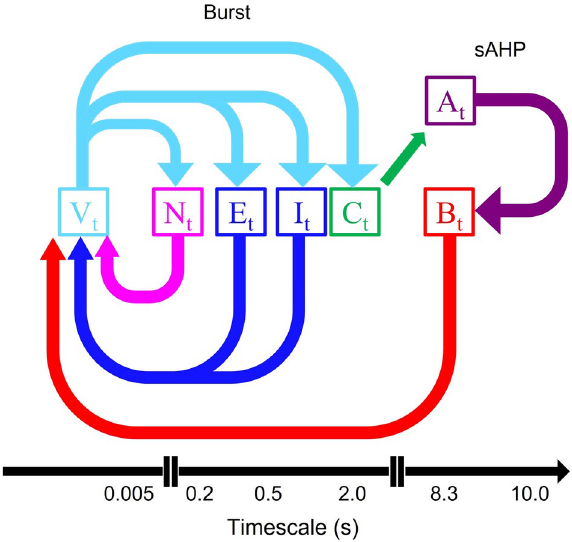
Figure 1. Model variables and relationships. A schematic of the relationships in the model. Each arrow represents the effect on a variable. Membrane voltage ( V t ) causes changed in potassium opening probability ( N t ), acetylcholine release ( E t ), GABA release ( I t ), and calcium influx ( C t ). Calcium affects cAMP concentration ( A t ) and TREK1 opening ( B t ). TREK1 ( B t ), acetylcholine ( E t ), GABA ( I t ), and potassium opening probability ( N t ), then affects